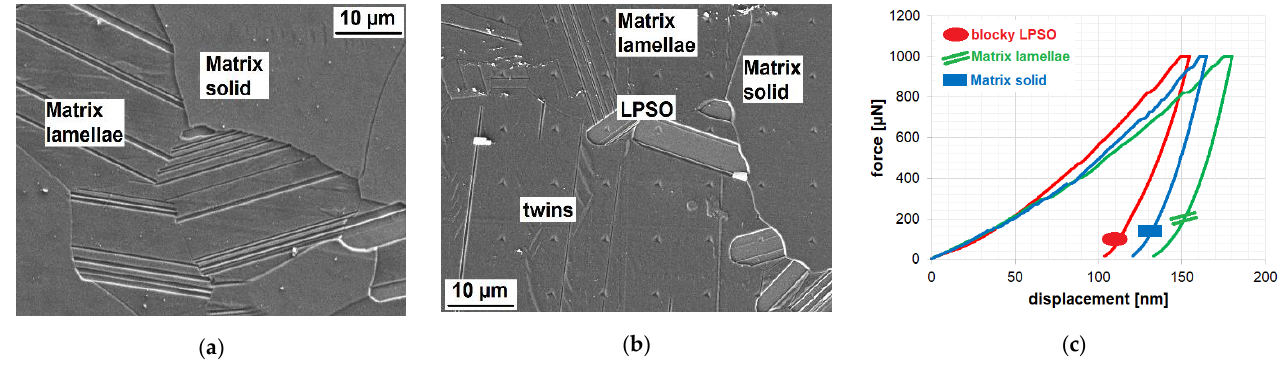
Figure 3. SEM micrographs of Mg-Dy-Nd-Zn-Zr alloy after heat treatment at 500 °C for ( a ) 120 h and ( b ) 96 h — magnified section of Figure 2a — and followed by quenching in 55 °C warm water. ( c ) Force – displacement curve of blocky LPSO and Mg matrix grains with LPSO lamellae and without obvious LPSO lamellae (solid), taken from indents shown in Figure 3b.